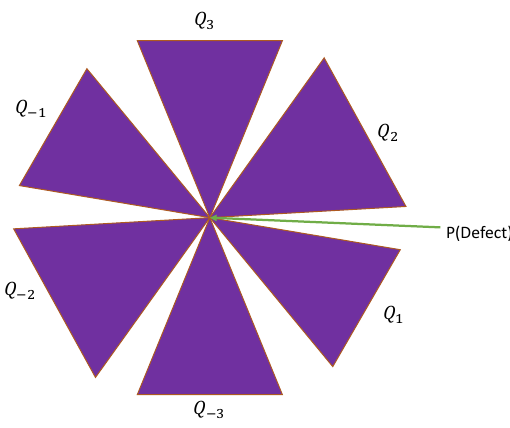
Figure 3 . Cartoon picture of the multiverse for n = 3 in AdS spacetimes. P is the ( d − 1) -dimensional defect and Karch-Randall branes are denoted by Q − 1 / 1 , − 2 / 2 , − 3 / 3